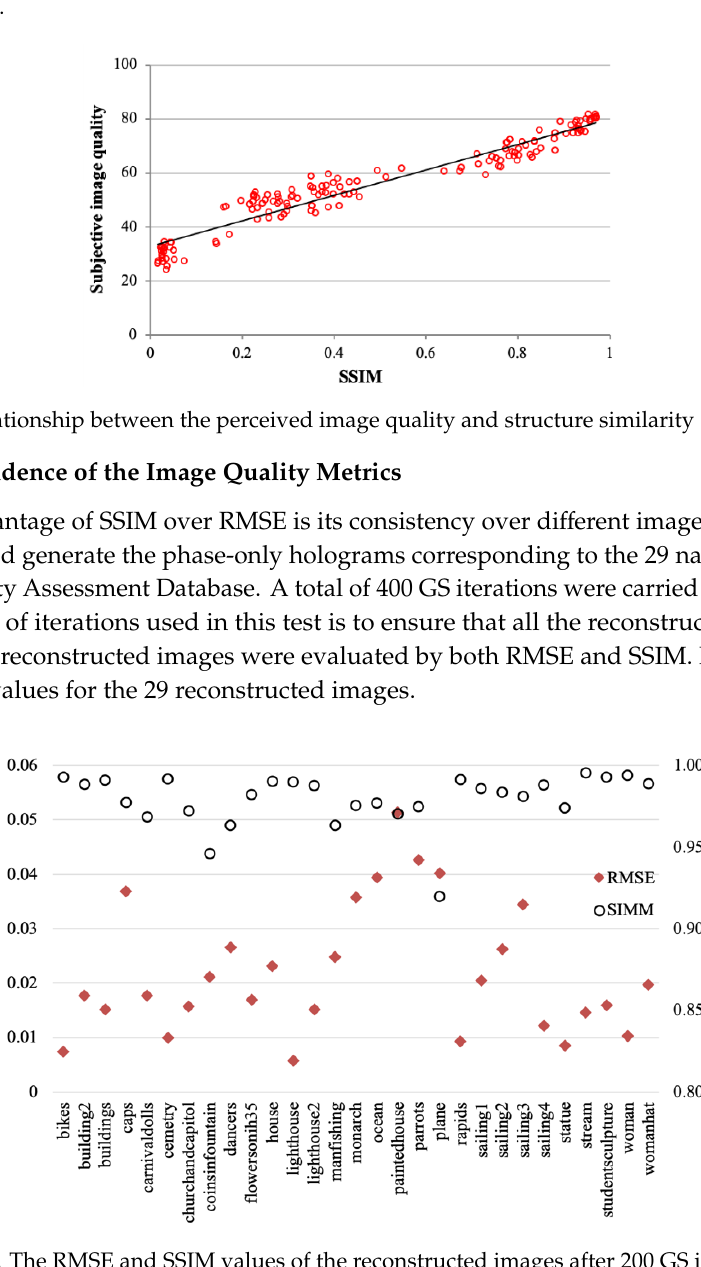
Figure 8. The RMSE and SSIM values of the reconstructed images after 200 GS iterations.